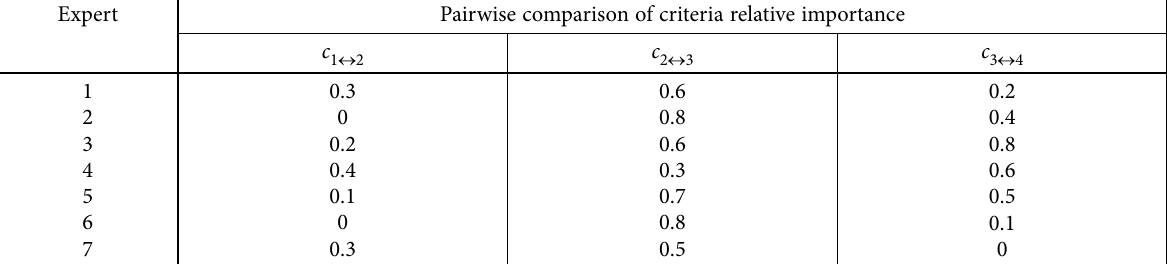
Table 3. Relative importance assessment in indicators’ pairs